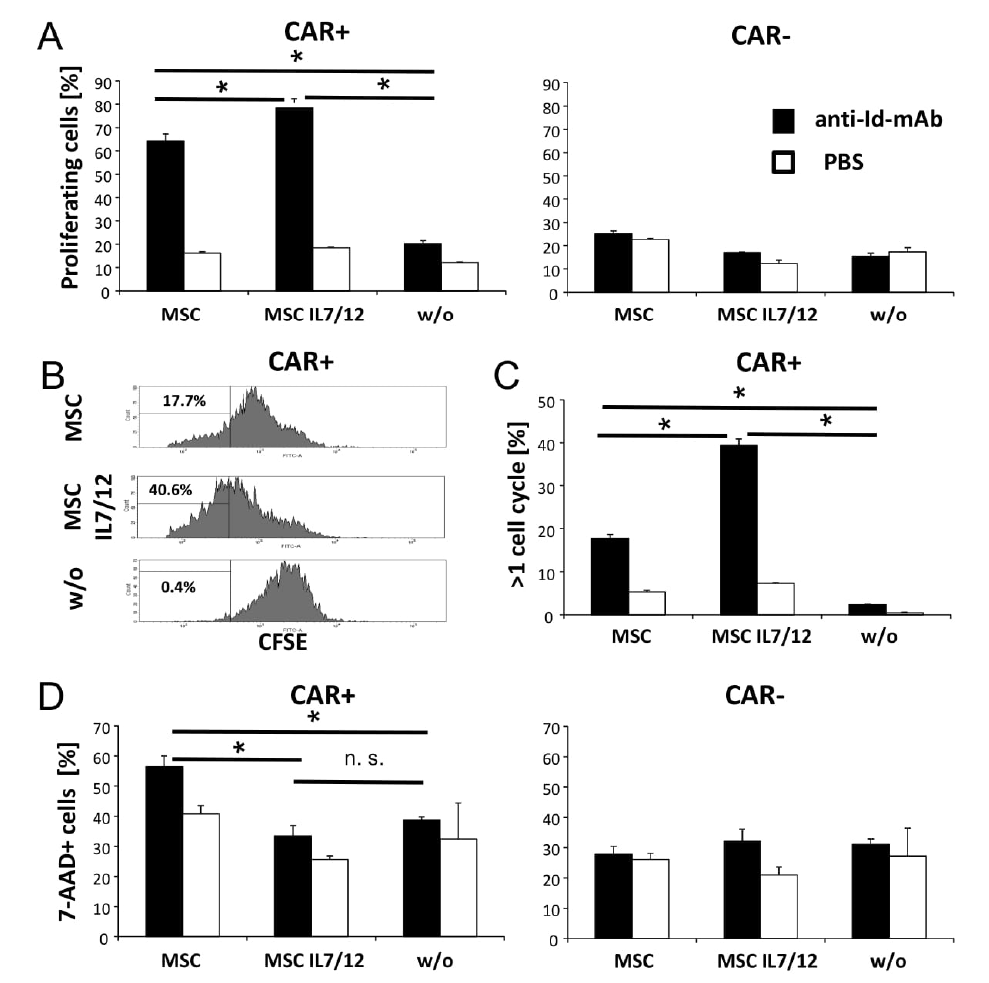
Figure 5. IL7 and IL12 secreting MSCs enhance CAR driven T cell proliferation and reduce activation induced cell death (AICD). Anti-CEA CAR T cells were CFSE labeled and co-cultivated (2.5 × 10 4 cells / well) with or without non-modified or IL7 / IL12-modified MSCs in 96-well plates (5000 cells / well) that were coated with the anti-idiotypic mAb BW2064 (4 µ g / mL) for CAR engagement or with PBS for control. After 5 days cells were recovered, stained with an anti-IgG-PE antibody to detect the CAR and analyzed by flow cytometry. The number of proliferating T cells was determined by CFSE dilution, dead cells were identified by 7-AAD staining (1 µ g / mL) and the number of proliferating cells was determined. ( A ) CAR T cell proliferation in presence or absence of MSCs; (b,c) number of rapidly cycling CAR T cells within the observation period; ( B ) flow cytometric histograms of a typical experiment after stimulation with the anti-idiotypic mAb, ( C ) summary of rapidly cycling CAR T cells. ( D ) AICD of CAR T cells in presence or absence of MSCs. Values represent the mean of replicates +/- standard deviation (SD). Significant differences were calculated by Student´s T test. * p < 0.05, n.s., not significant.